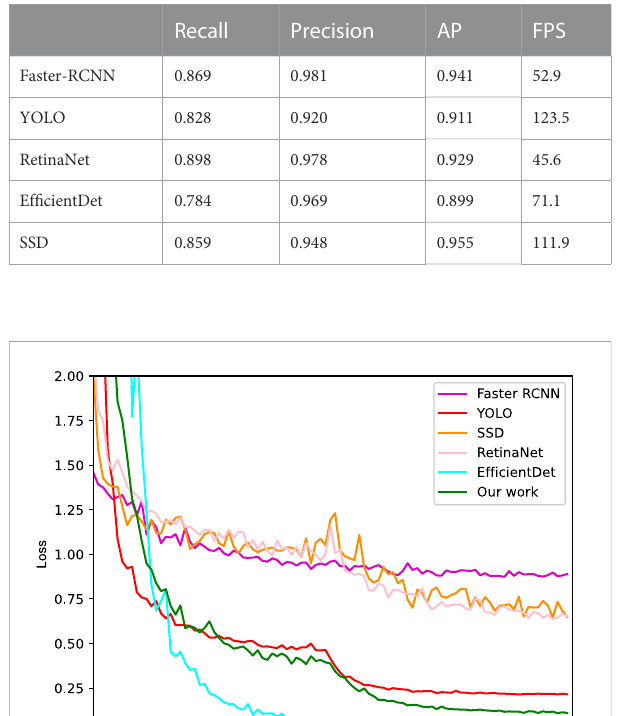
TABLE 2 Ablation